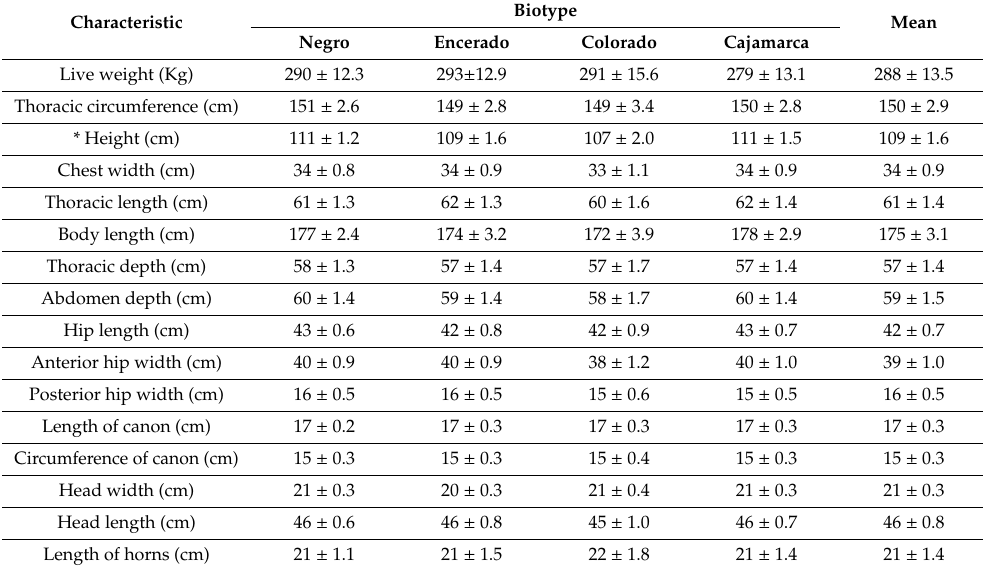
Table 2. Live weight and morphometric characteristics from the four biotypes of Criollo Lojano bovine (mean ± standard error).